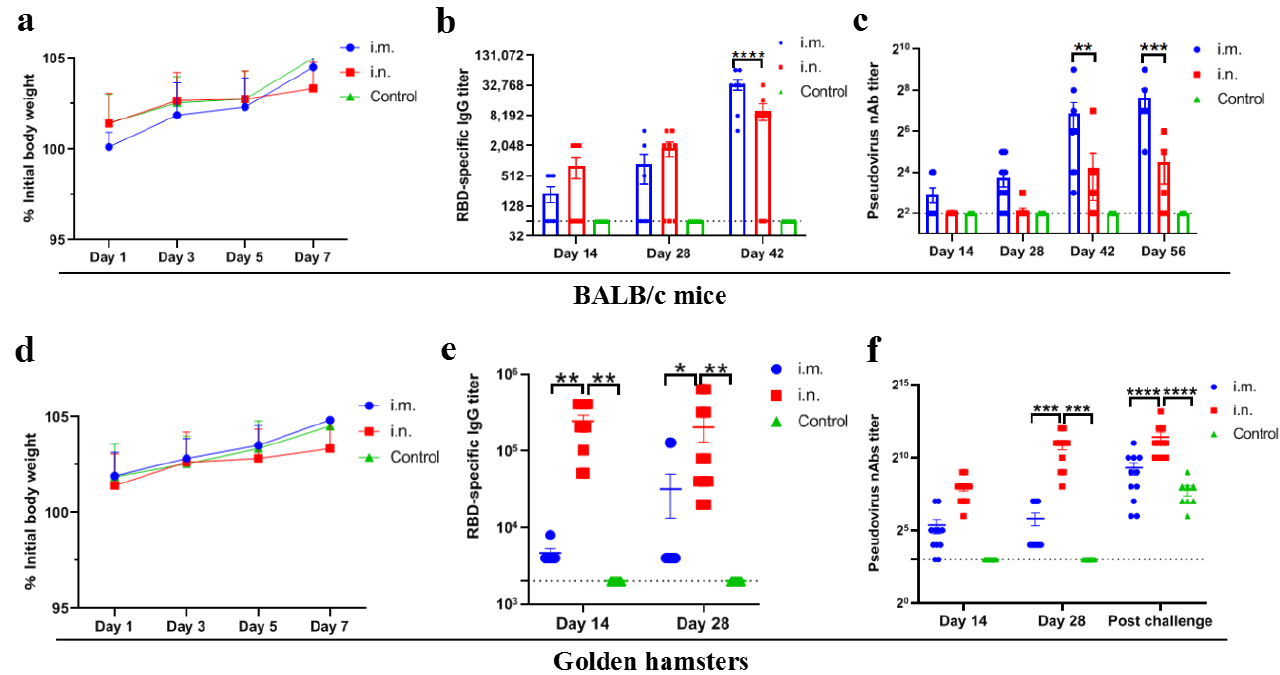
Figure 2. Virus-specific antibody and neutralizing antibody induced by rVSVΔG-S. ( a ) Weight change monitoring of BALB/c mice following vaccination for 7 days. i.m., i.n. and control refer to i.m. ( n = 10), i.n. inoculation group ( n = 10) and PBS inoculation control group ( n = 10), respectively same in ( b – f ). ( b ) RBD-specific IgG in mouse serum samples at 14, 28 and 42 dpv. ( c ) nAbs in the serum of mice at 14, 28, 42 and 56 dpv. ( d ) Weight changes in golden hamsters 7 days after vaccination. ( e ) RBD-specific IgG in the serum of golden hamsters at 14 and 28 dpv. ( f ) nAb titers in hamster serum samples at 14, 28 dpv and post-SARS-CoV-2 challenge. Data are presented as mean ± SEM. (* p < 0.05, ** p < 0.01,*** p < 0.001, **** p < 0.0001) .